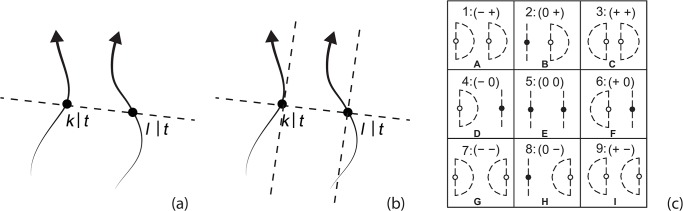
Two MPOs, k and l, and their trajectories are used to form QTCB base relations.The frame of spatial reference is illustrated by the dashed line. (a), QTCC setting (b). The frame of spatial reference is illustrated by the dashed line. Nine QTCB base relations (c).